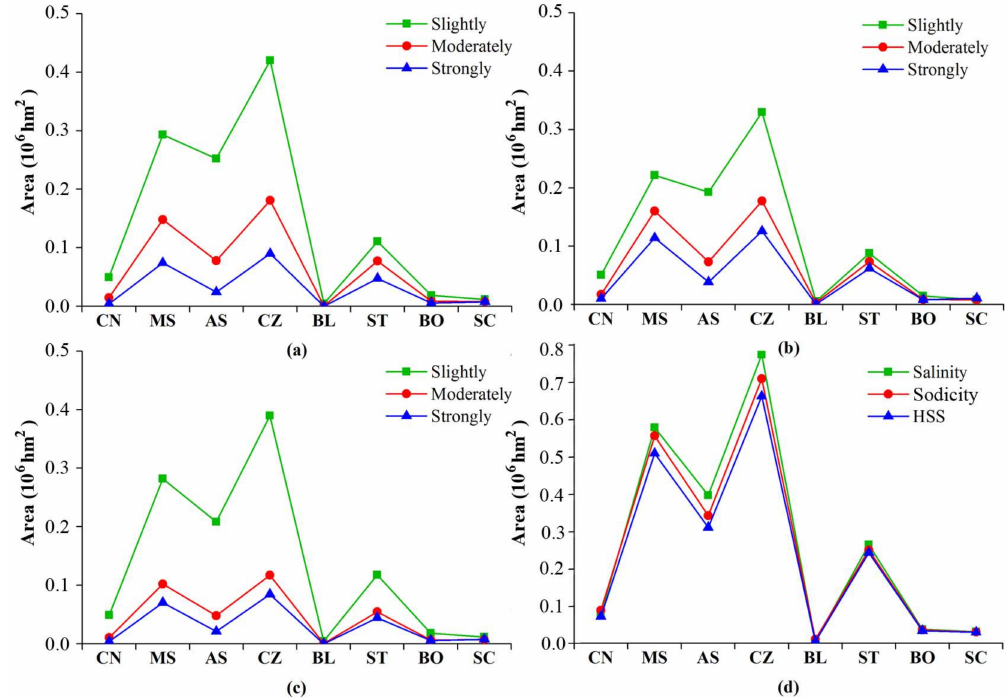
Figure 7. The areas affected by soil salinity, sodicity, and HSS at different levels with regard to soil types. ( a ) Salinity ( b ) Sodicity ( c ) HSS ( d ) Affected soil types (CN: Chestnut soil, MS: Meadow soil, AS: Aeolian soil, CZ: Chernozem, BL: Black soil ST: Solonetz, BO: Bog soil SC: